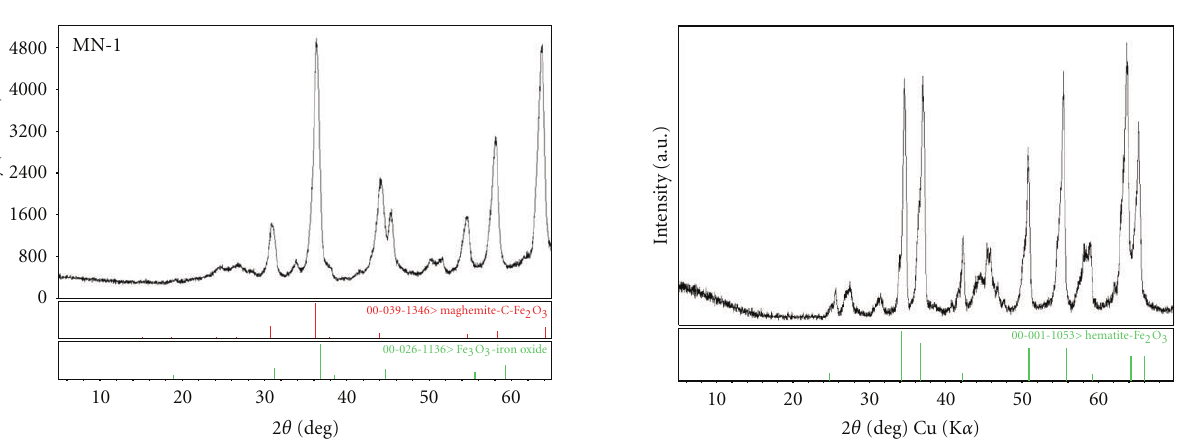
Figure 8: XRD pattern of maghemite coated anthracite synthesized using combustion reaction (MN-1 sample).